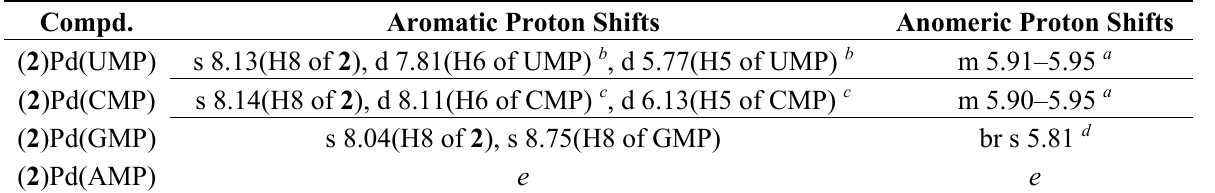
Table 4. Chemical shifts for the aromatic and anomeric protons of the mixed ligand Pd 2+ complexes of 2,6-bis(1-methylhydrazinyl)purine riboside ( 2 ) with